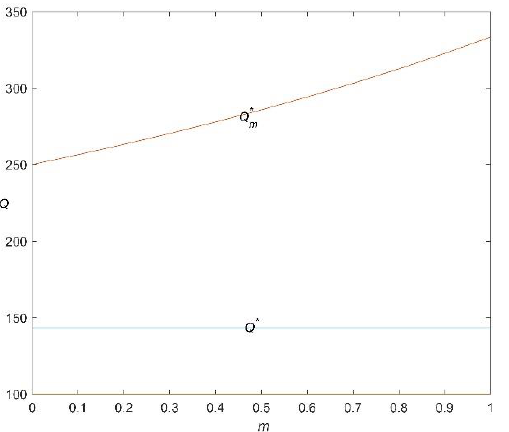
Figure 3. Optimal purchase quantity Q ∗ and Q ∗ m under different fixed-term contract buyer default rate m .